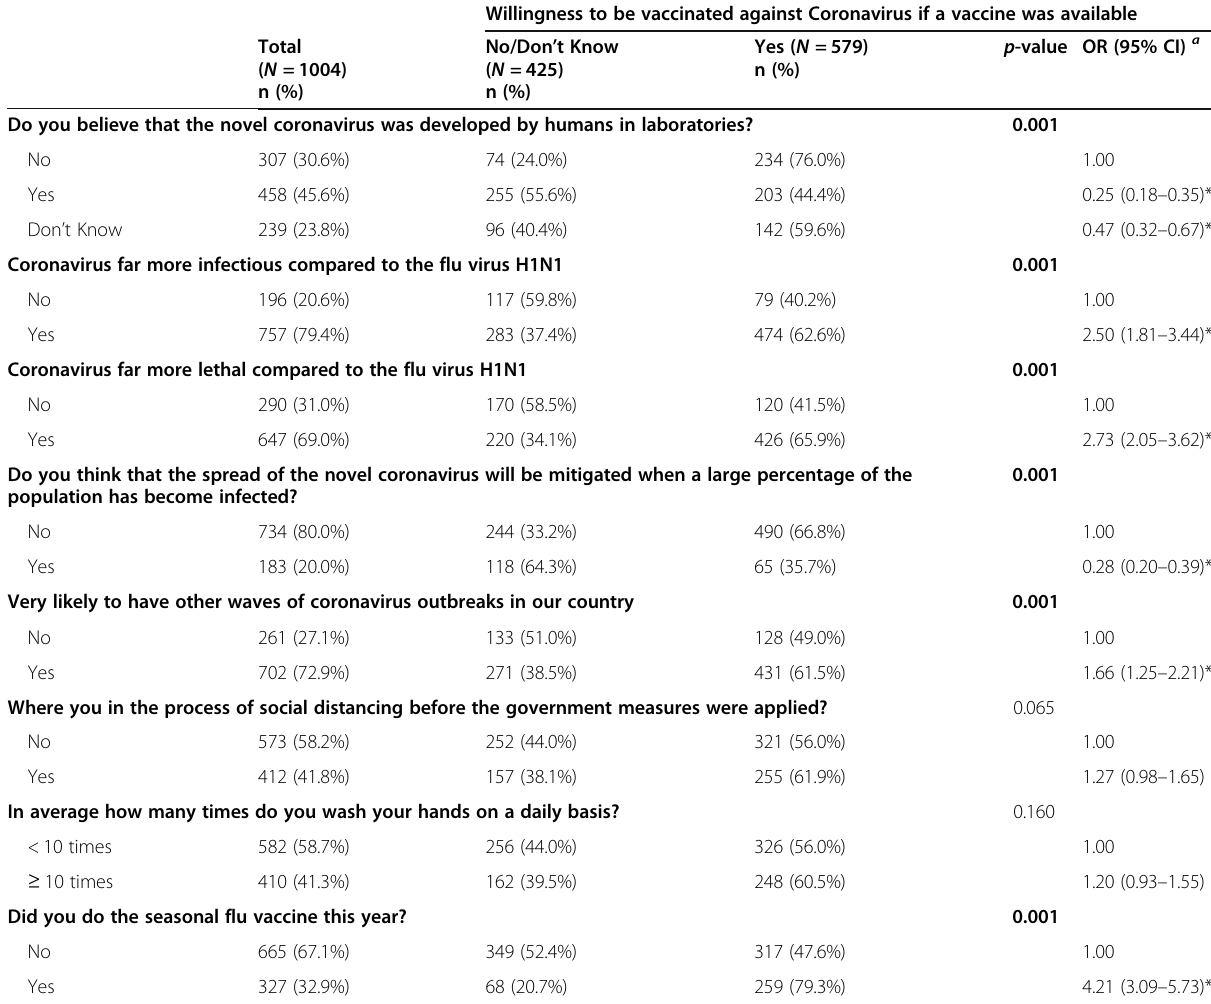
Table 3 Associations between attitudes & practices and willingness of respondents to get vaccinated for COVID-19 in Greece Willingness to be vaccinated against Coronavirus if a vaccine was available Total No/Don ’ t Know ( N = 1004) ( N = n (%)